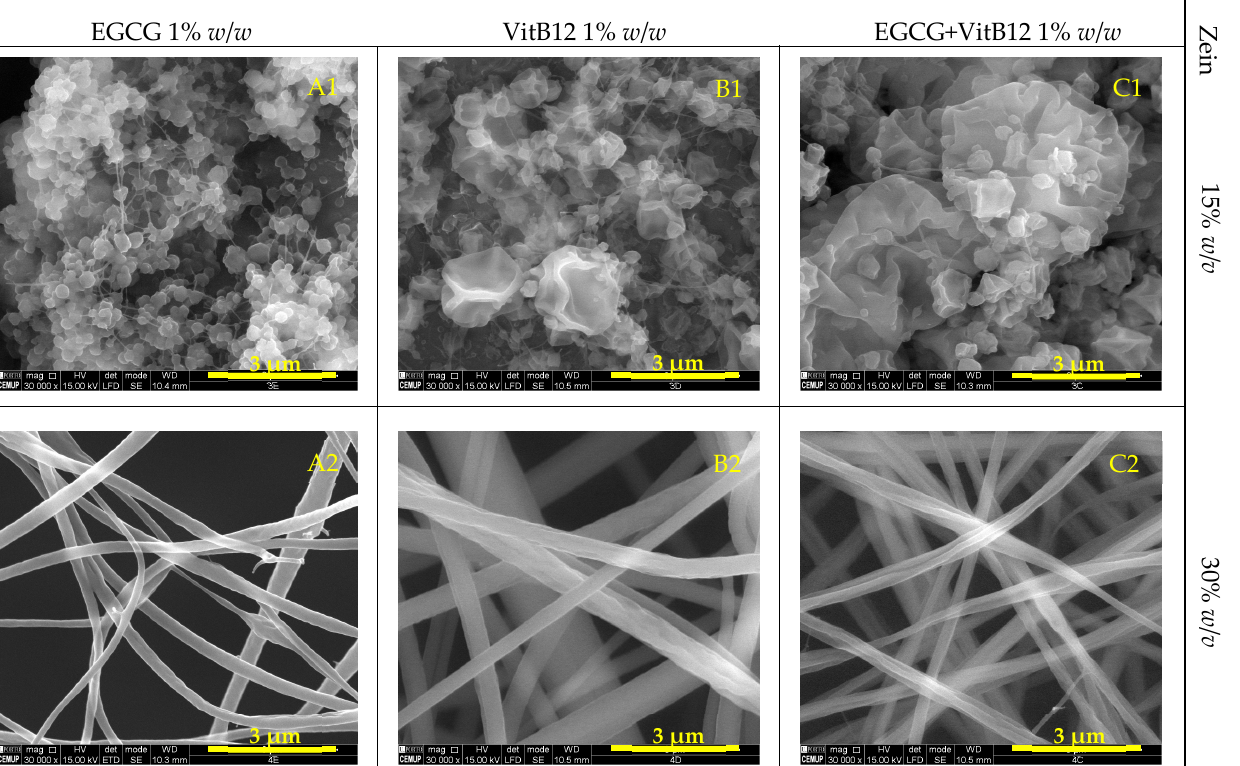
Figure 2. SEM images of microstructures (pressure controlled samples) containing 15% w/v ( A1 – C1 ) and 30% w / v zein ( A2 – C2 ), and EGCG, VitB12 and (EGCG + VitB12). Magnification of 30,000×, beam intensity (HV) 15.00 kV, distance between the sample and the lens (WD) less than 10.6 mm, and scale bar of 3 μ m.